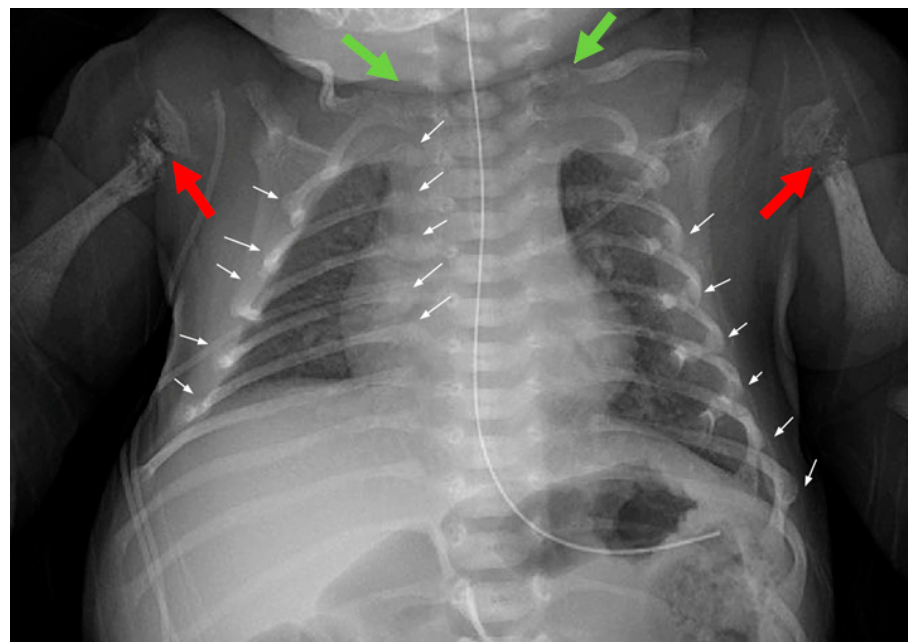
Figure 4. The chest X-ray at 7 days of age showed bilateral fractures of the clavicular heads (green arrows) and likely multiple posterior rib fractures, including the right 2nd–5th ribs, the right lateral 2nd–7th ribs, and the left 3rd–9th ribs (white arrows). Multiple fractures involved the bilateral proximal humeral diaphyses with poorly formed callus at the fracture margins and impaction of the fractures (red arrows). Holick MF, copyright 2021.